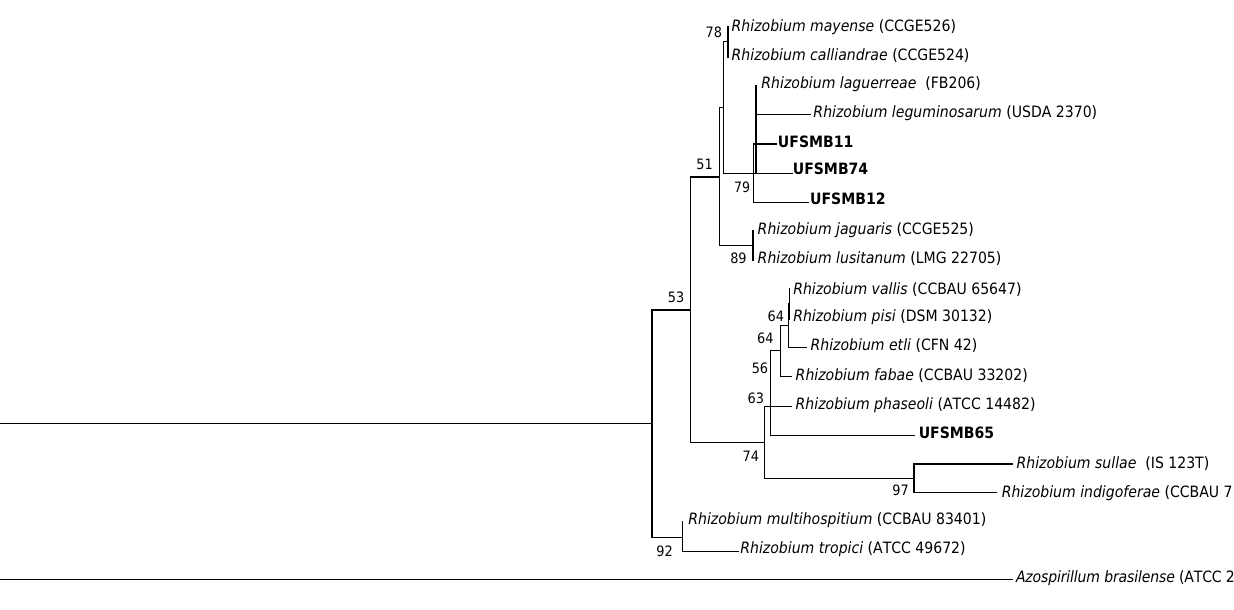
Figure 5. Phylogenetic tree based on 16S rRNA gene sequence similarity of Rhizobium strains. The phylogenetic tree was built using neighbor-joining and Kimura 2-parameters (K2P). Numbers on branches indicate bootstrap values, with a total of 1000 replicates; only values greater than 50 are shown. Bar indicates 2 substitutions per 100 nucleotides.